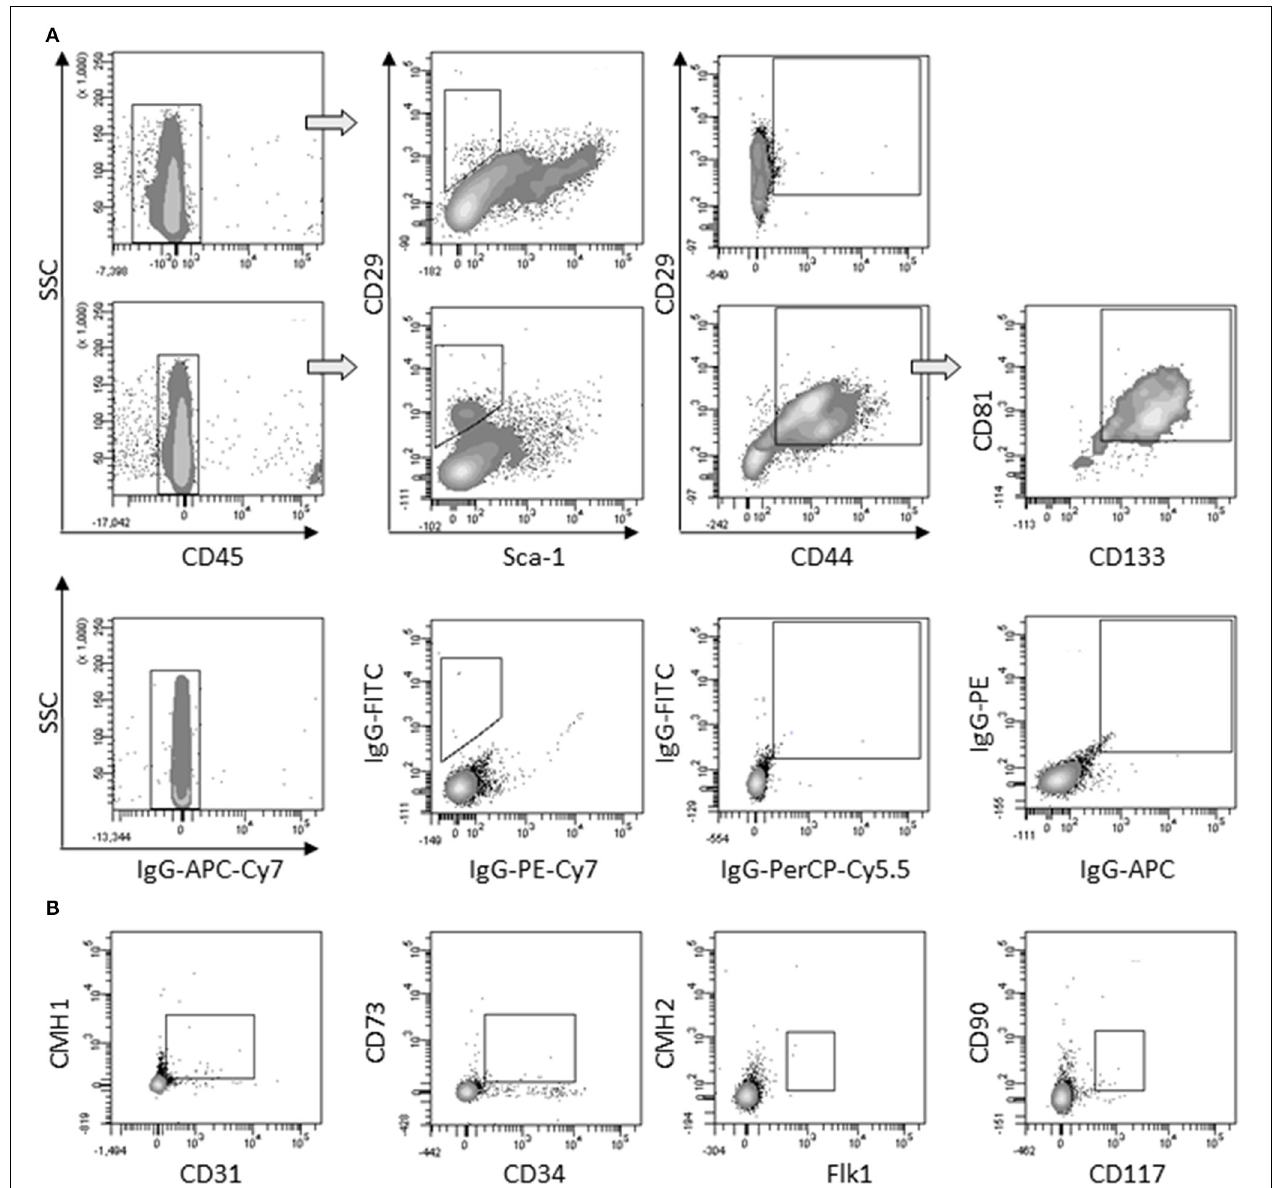
FIGURE 4 | Characterization of large round multi-nucleated cells ( c cells). (A) Flow cytometry analysis of surrounding cells (upper panels) and myogenic clusters (medium panels) picked off 8 days after plating. Cells were gated on CD45 − population and analyzed for CD29/Sca-1/CD44 expression. CD81/CD133 cells were gated on CD29 + /CD44 + cells. Representative dot